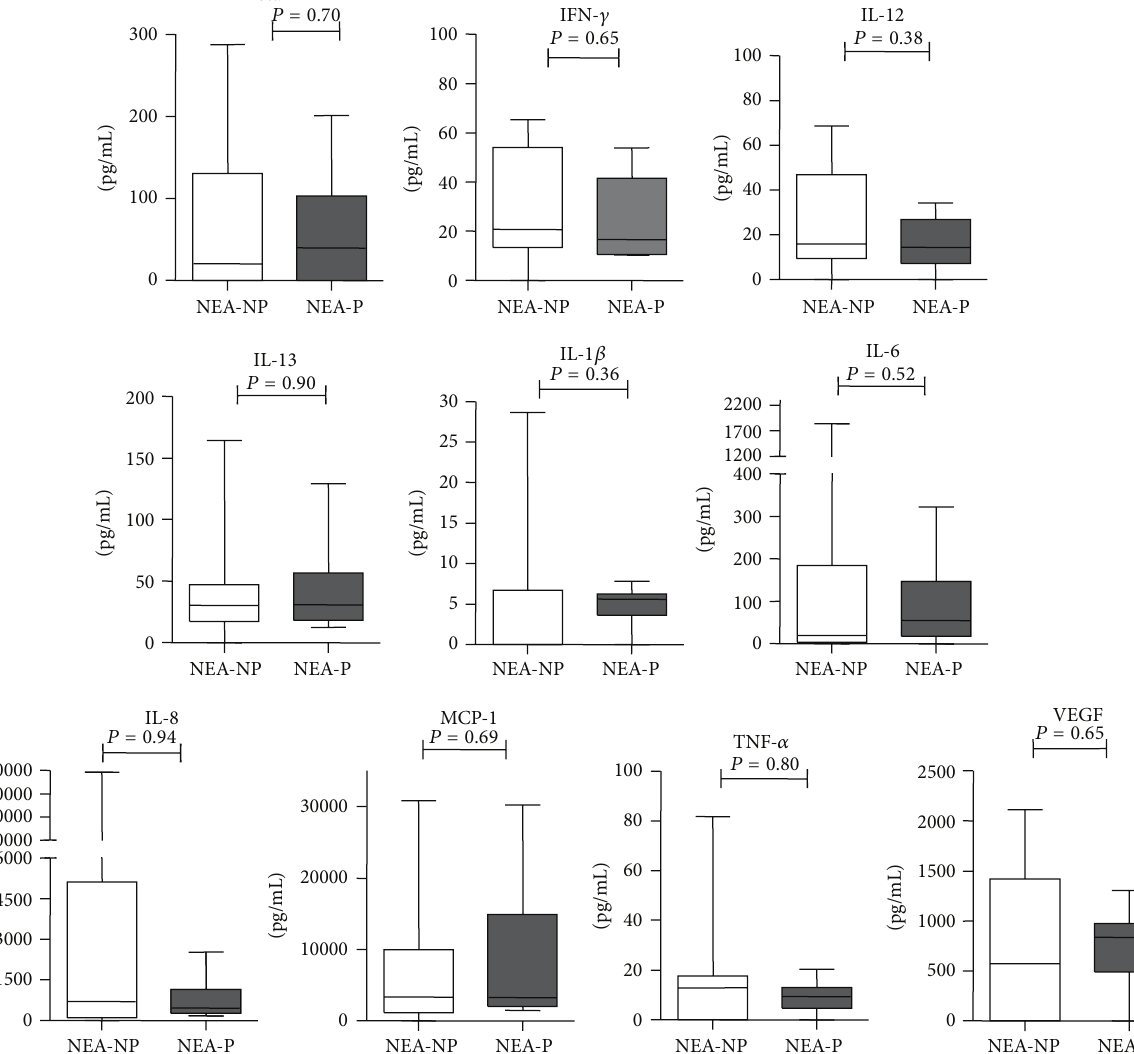
Figure 3: Concentrations of soluble mediators in aspirates of endometrial secretions in the NEI-NP and NEI-P groups. The expression of cytokine profiles [eotaxin, IFN- 𝛾 , IL-1 𝛽 , IL-6, IL-8, IL-12 (p70), IL-13, TNF- 𝛼 , MCP-1, and VEGF] in endometrial secretions obtained before ET from 28 patients (NEA-NP: 18; NEA-P: 10) was analyzed. The box plot horizontal lines represented the median and the 25th–75th percentiles. The 𝑃 values obtained are the results of the Mann-Whitney 𝑈